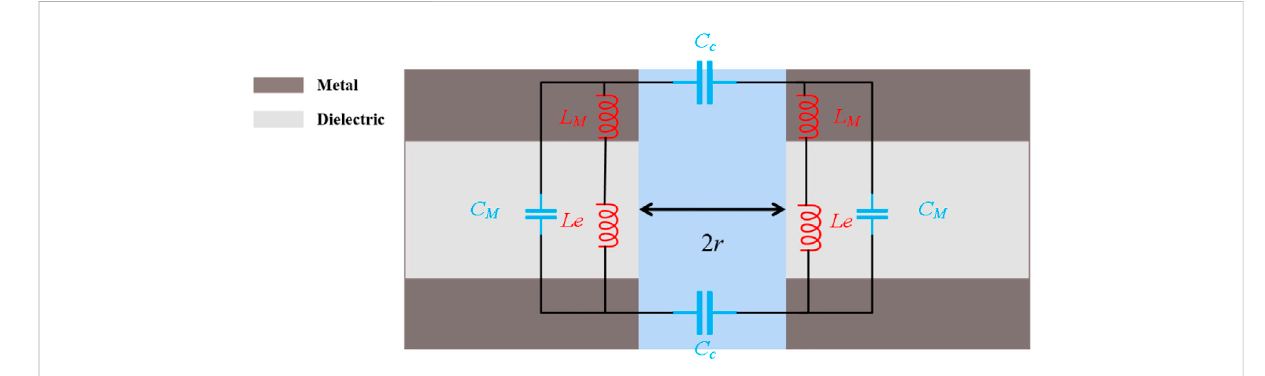
FIGURE 6 MPs resonant equivalent LC circuit model